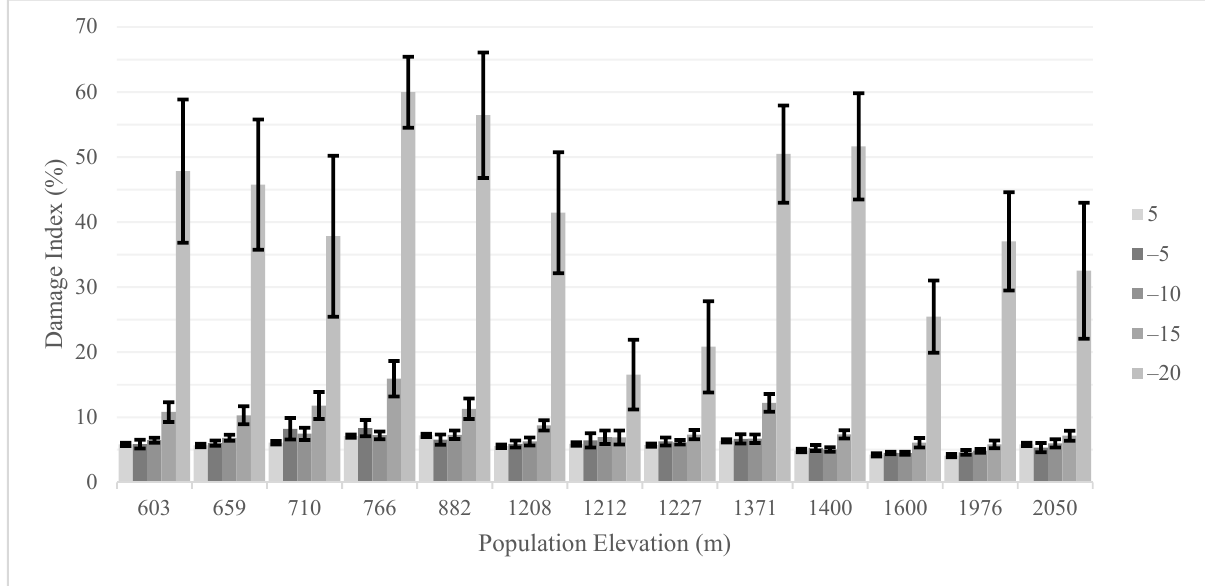
Figure 4. Mean (±SE, standard error) damage index (%) of frost damage for koa populations from a range of elevations and test temperatures. Tissue samples were from non-acclimated seedlings from 13 populations. Test temperatures consisted of a control at 5 °C, and four freezing temperatures: − 5, − 10, − 15, and − 20 °C.